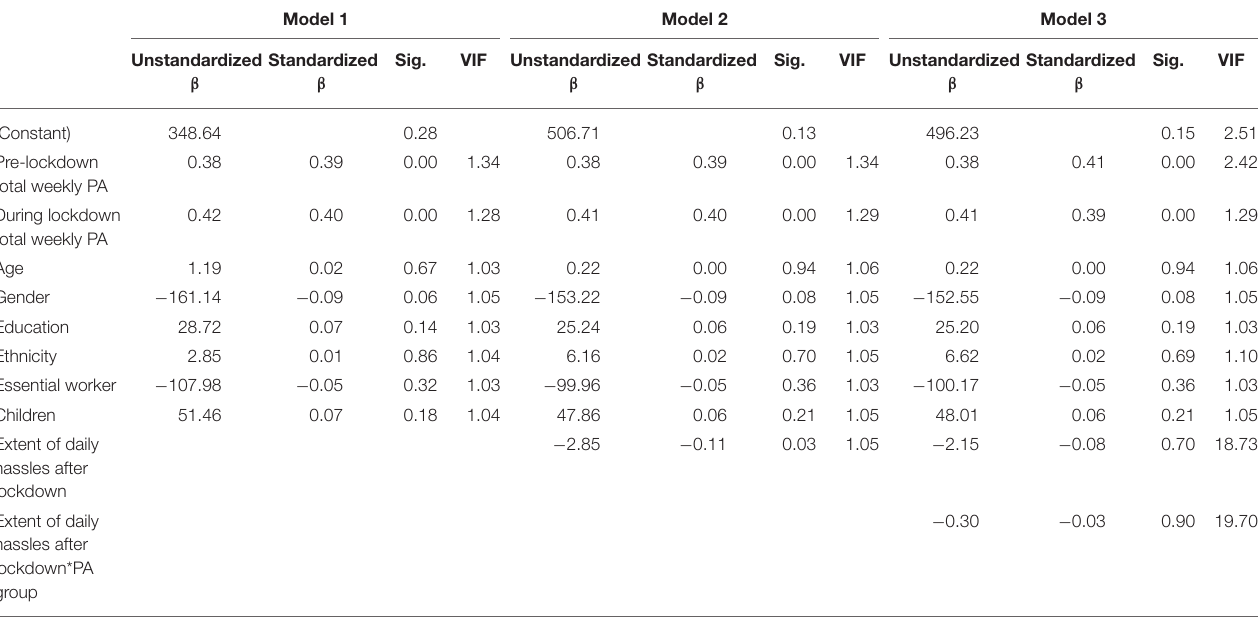
TABLE 5 | Multiple regression results investigating relationships between daily hassles and PA behavior